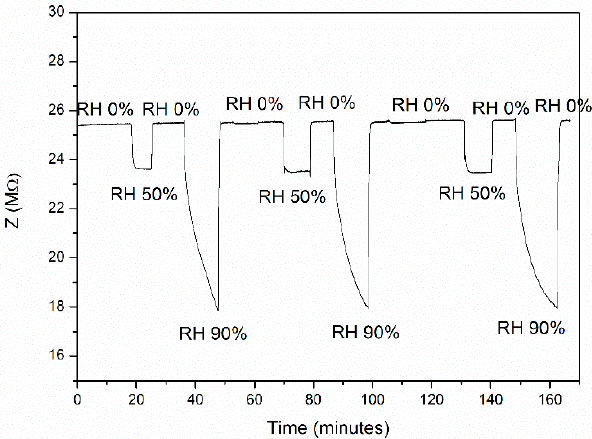
Figure 11. Impedance variation under 3 cycles of humidity pulses at 50% and 90% of relative humidity after 1 year of aging.